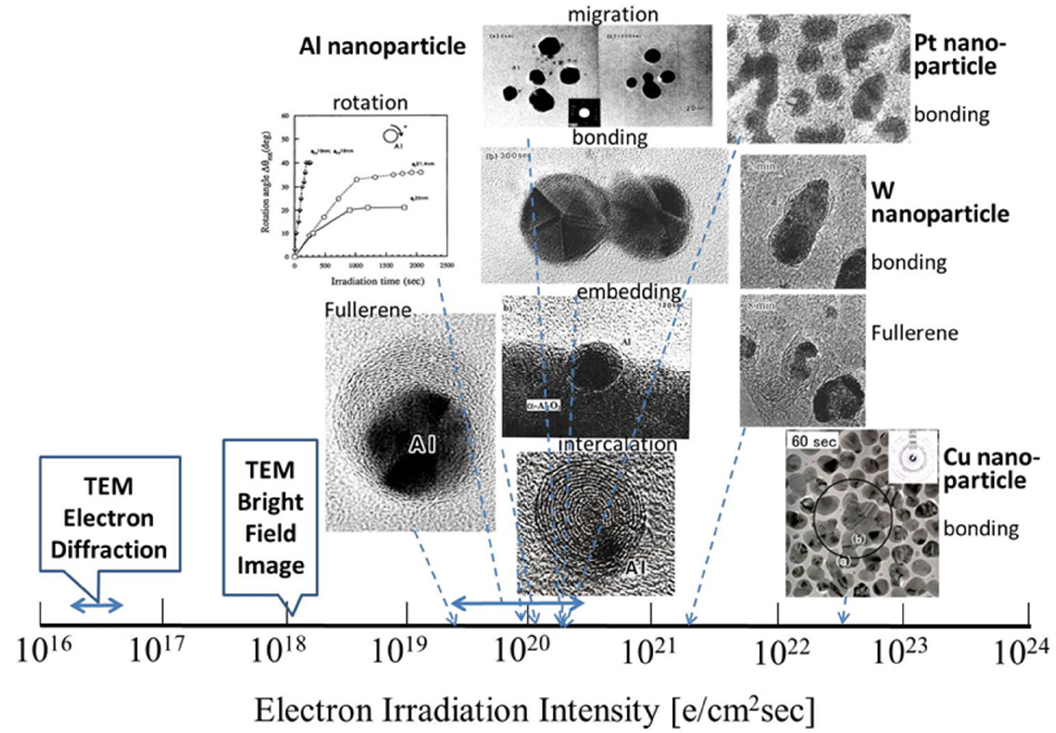
Figure 29. Manipulation of nanomaterials by electron irradiation in a TEM. Nanostructures can be controlled in an electron excited reaction field through migration, bonding, rotation, revolution, embedding, fullerene formation and intercalation. The electron irradiation intensity ranged between 10 19 –10 23 e/cm 2 s depending on the size and weight of the material.